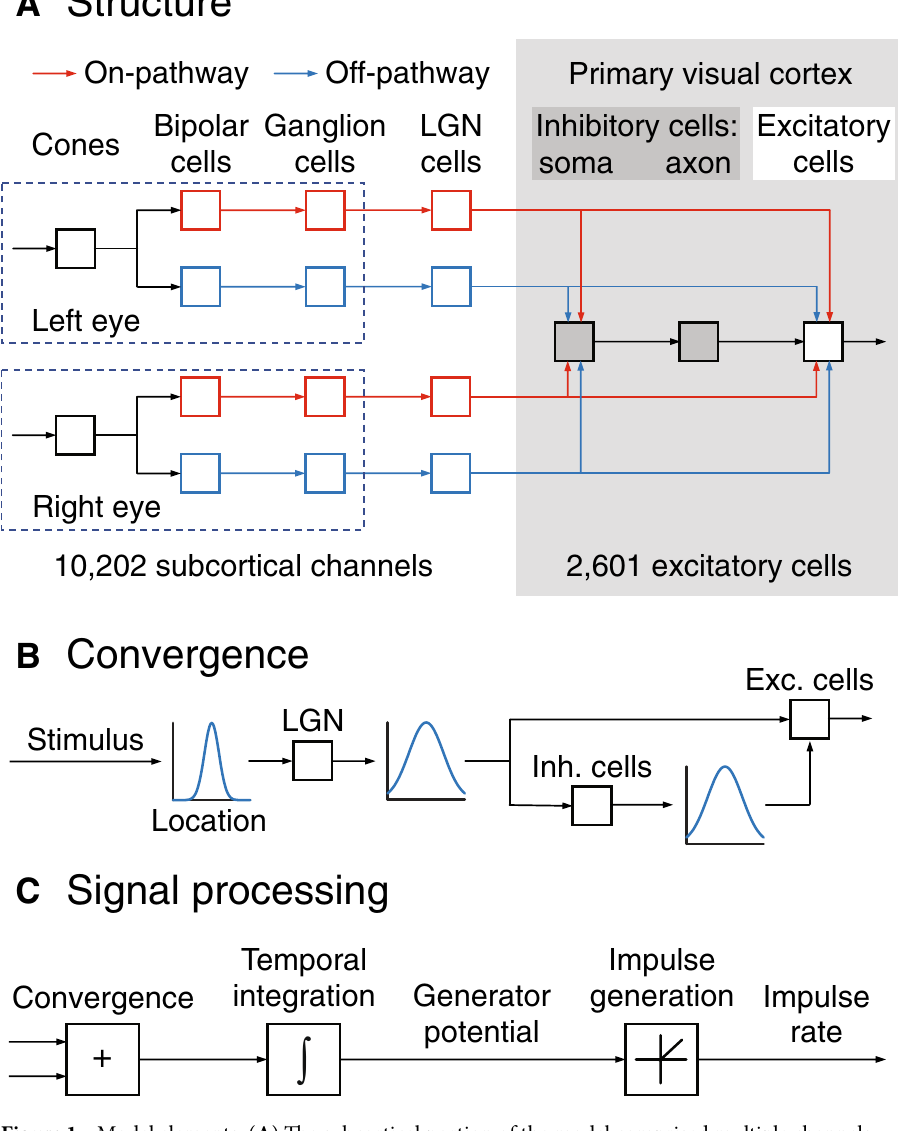
Figure 1. Model elements. ( A ) The subcortical portion of the model comprised multiple channels, with on- and off-centre cells and both eyes represented. All channels converge onto all cortical cells, both inhibitory and excitatory. Inhibitory cells, in turn, converge onto excitatory cells. ( B ) Convergence functions represent the attenuation of a presynaptic signal as a function of its visual field distance from its postsynaptic target. A single function is used for all subcortical sources of convergence and a second, wider, function governs convergence onto excitatory cells from both subcortical and inhibitory sources. ( C ) The model is mathematically defined by a series of differential equations which were numerically integrated to calculate time courses. The flow diagram shows the sequence of signal processing in a typical neuron: convergence of presynaptic signals, integration, and rectification of the generator potential to obtain impulse